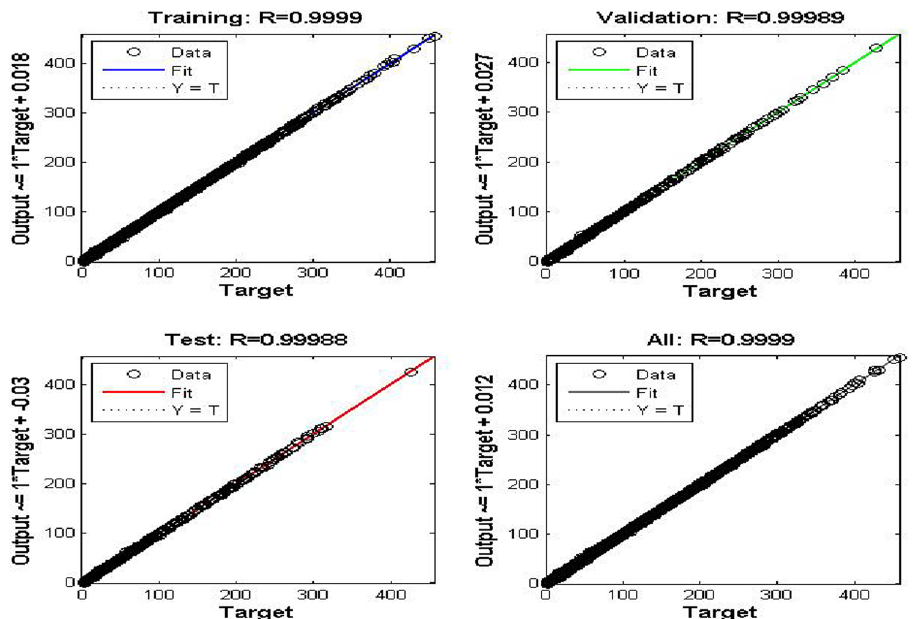
Fig. 6 Results of type-2 neural network using three hidden layers